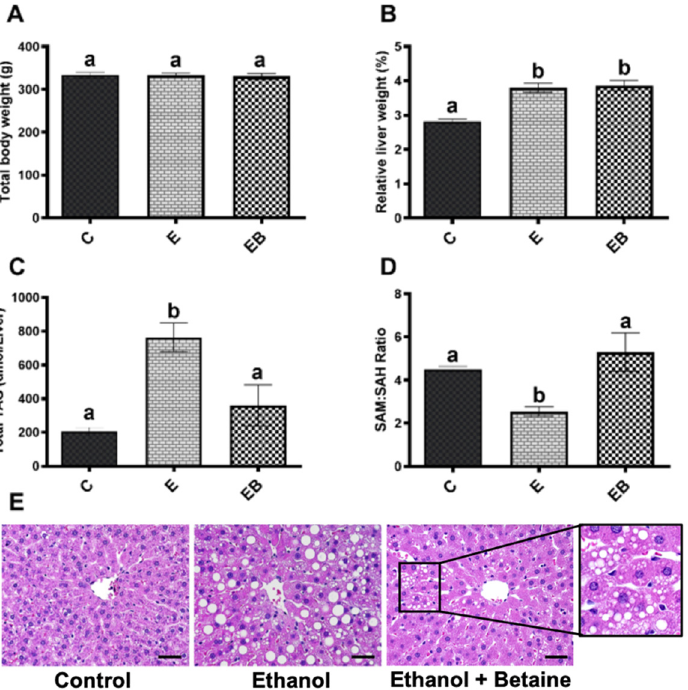
Figure 1. ( A ) Body weight, ( B ) relative weight of liver, total hepatic ( C ) triacylglycerol (TAG), and ( D ) S-adenosylmethionine (SAM):S-adenosylhomocysteine (SAH) ratio of rats fed control (C), etha- nol (E), or betaine-supplemented ethanol (EB) diet. ( E ) Photomicrograph of representative H&E-